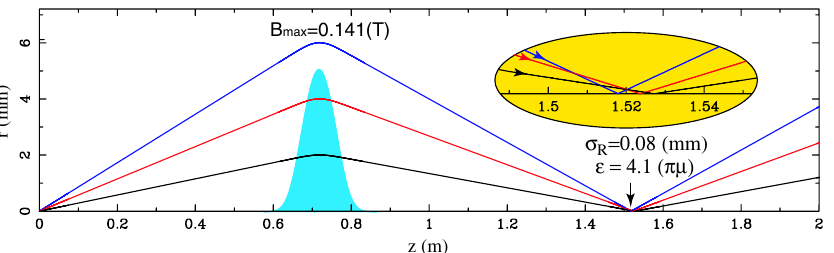
FIG. 8. (Color) Probe particle trajectories of the beam in the static solenoid. " is normalized rms transversal emittance after the lens; (cid:6) is rms spot size in the focal point. R